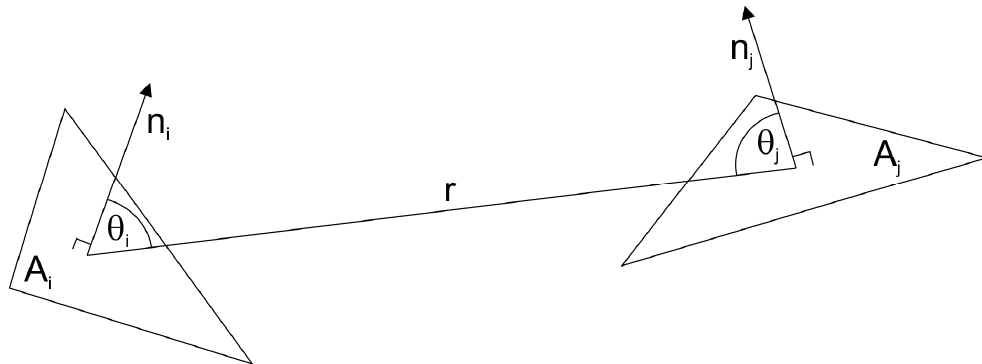
Figure 6. Calculation of form factors F ij (own